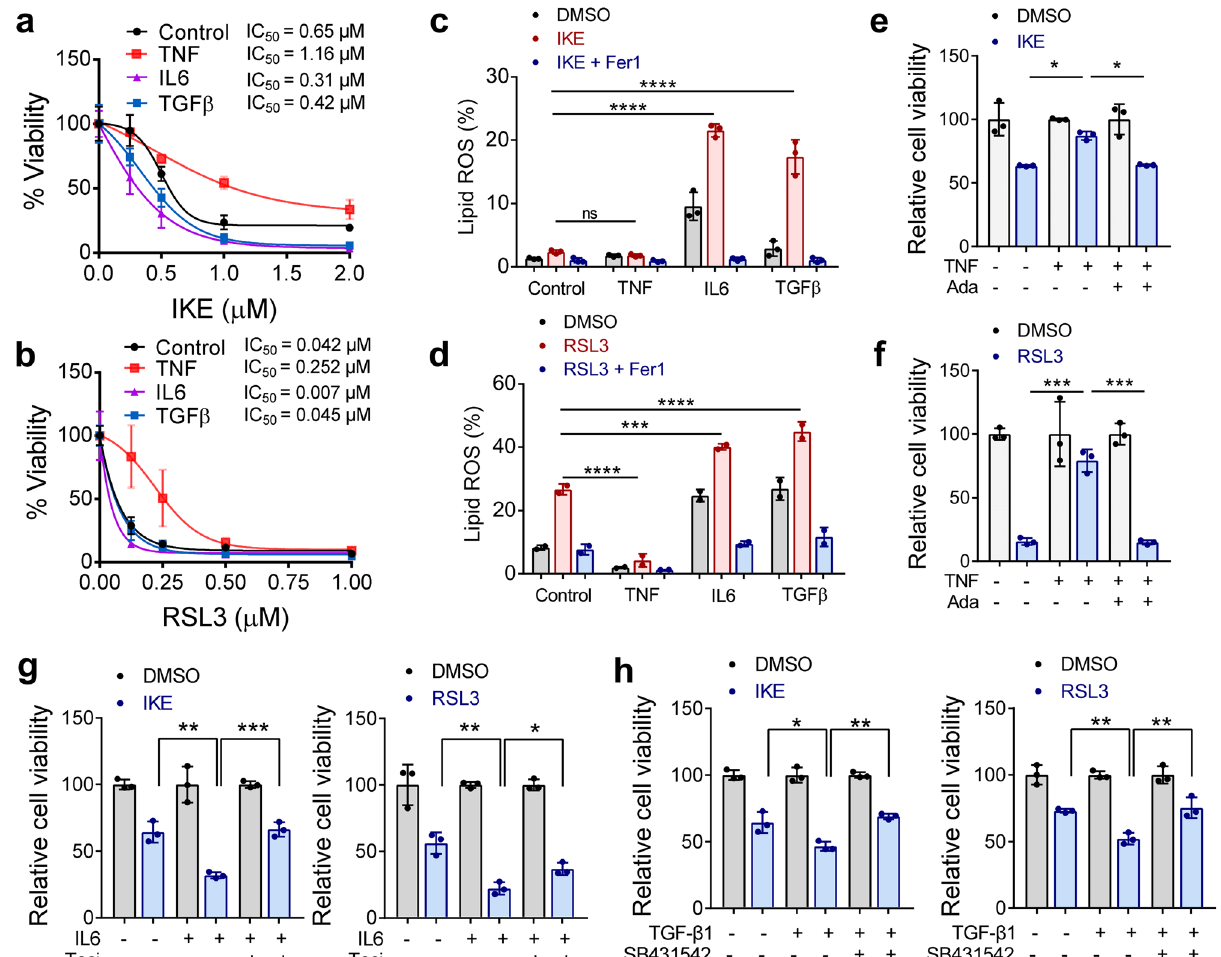
Fig. 5 TNF protects RA fi broblasts from ferroptosis while IL-6 and TGF- β sensitize fi broblasts to ferroptosis. a , b Relative viability of fi broblasts derived from RA patients and primed with TNF, IL-6, or TGF- β (20 ng/ml) for 72 h, followed by treatment with different concentrations of IKE or RSL3. Cell viability was assayed by measuring cellular ATP levels at 26 h (IKE) ( a ) or 12 h (RSL3) ( b ) after treatment. n = 3 biologically independent samples per condition. IC 50 values were calculated using nonlinear regression analysis. c , d Cells were treated as indicated for 18 h (IKE, 1 μ M) ( c ) or 4 h (RSL3, 0.125 μ M) ( d ) in the presence of the ferroptosis inhibitor Ferrostatin-1 (Fer1) (1 μ M) and lipid ROS accumulation was measured by BODIPY C11 staining coupled with fl ow cytometry. n = 2 biologically independent samples per condition. ns, P > 0.9999, **** P < 0.0001, *** P = 0.0007; one-way ANOVA followed by multiple comparisons. e , f The relative viability of fi broblasts primed with TNF in the presence of the anti-TNF blocking antibody adalimumab (Ada) for 72 h, followed by treatment with IKE ( e ) or RSL3 ( f ). n = 3 biologically independent samples per condition. * P = 0.0183, 0.0216 (left to right), *** P = 0.0003, 0.0002 (left to right); one-way ANOVA followed by multiple comparisons. g Relative viability of fi broblasts primed with IL-6 in the presence of the anti-IL- 6 receptor monoclonal antibody tocilizumab (Toci), followed by treatment with IKE or RSL3. n = 3 biologically independent samples per condition. Left, ** P = 0.0011, *** P = 0.0008; right, ** P = 0.0011, * P = 0.0182; one-way ANOVA. h Relative viability of fi broblasts primed with TGF- β in the presence of the ALK receptor inhibitor SB431542 followed by treatment with IKE or RSL3. n = 3 biologically independent samples per condition. Left, * P = 0.0131, ** P = 0.0042; right, ** P = 0.0067, ** P = 0.0040; one-way ANOVA followed by multiple comparisons. All bar graphs are represented as mean ± SD. Source data are provided as a Source data fi